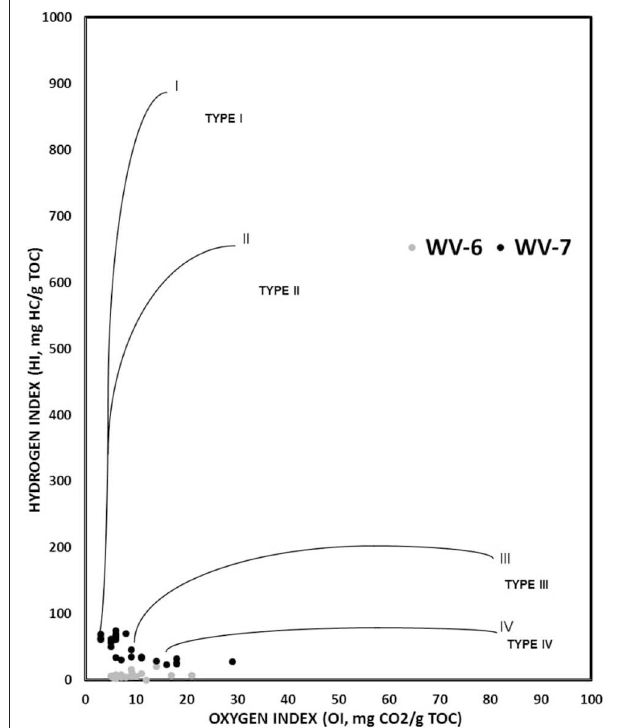
FIGURE 4 | Van - krevelen diagram for WV-6 and WV-7